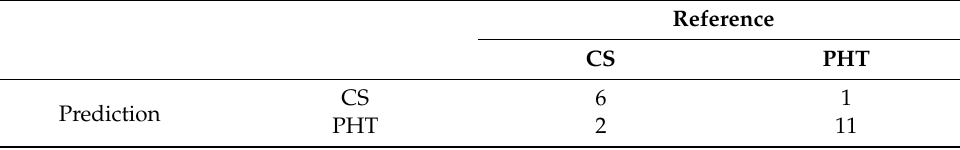
Table 4. Confusion matrix showing the actual and predicted labels for CS vs.